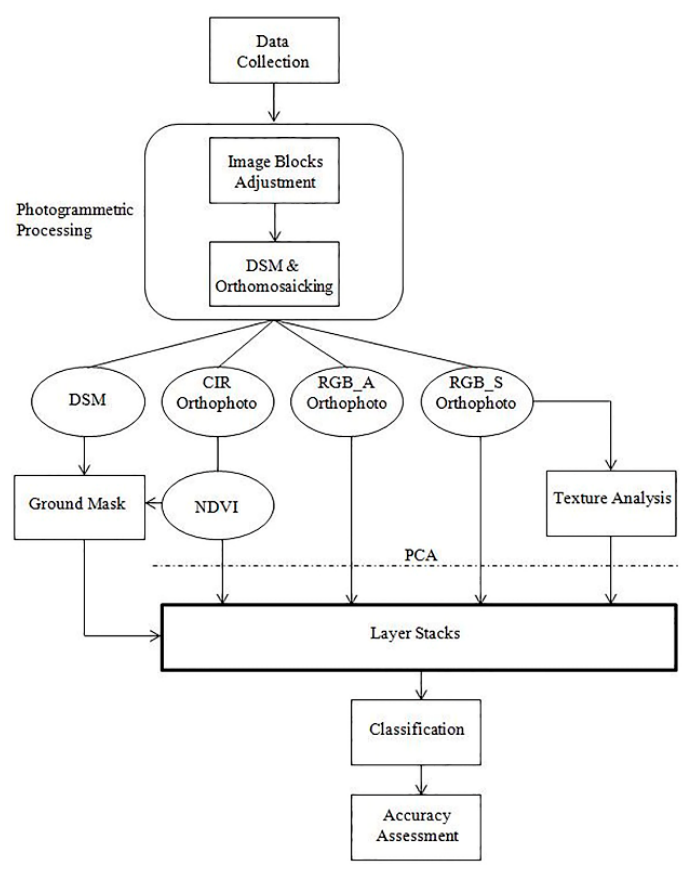
Figure 1. General workflow.